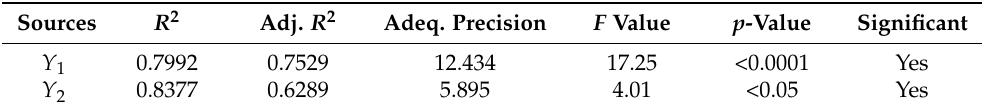
Table 4. ANOVA results for models.